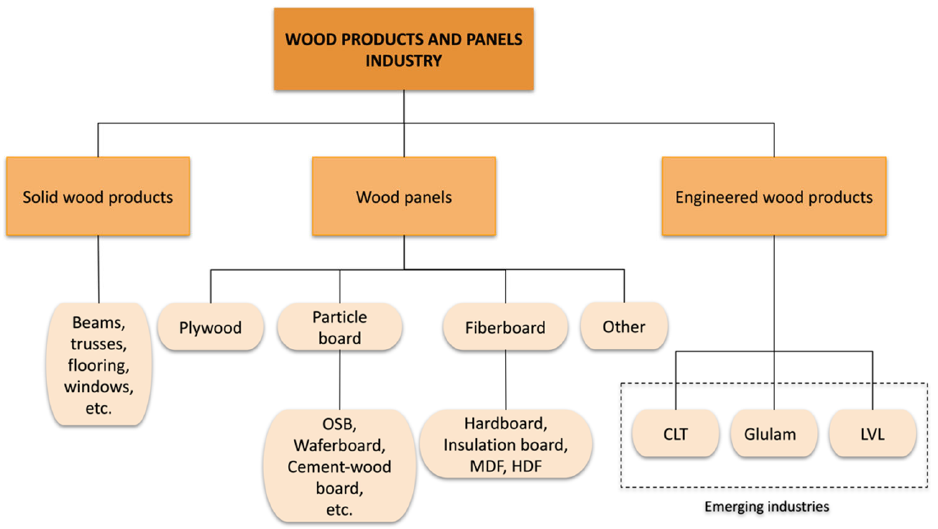
Figure 3. Main current products and emerging technologies from the Brazilian solid wood products and panels industry.